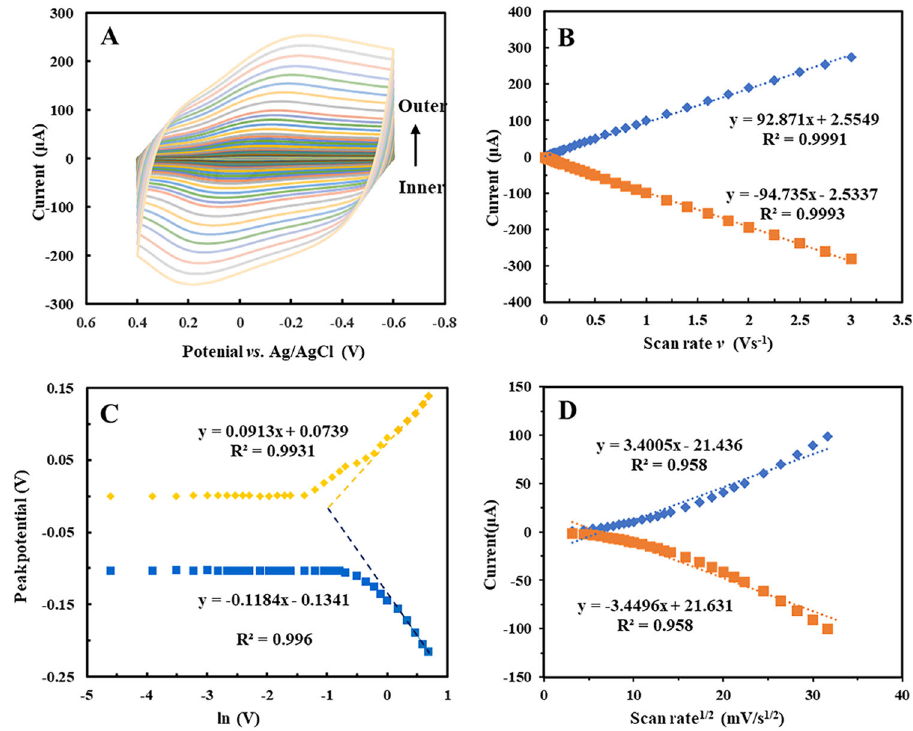
Figure 3. ( A ) CVs of the NF/GDH/IL/mPEG-fMWCNT-modified GCE at different scan rates. ( B ) Plot of peak current (I p ) versus scan rate ( υ ). ( C ) Plot of peak potential (E p ) versus ln υ . ( D ) Plot of peak current versus scan rate 1/2 . The experiments were conducted in a PBS solution (50 mM, pH 7.0) versus Ag/AgCl. at 25 ± 1 °C.